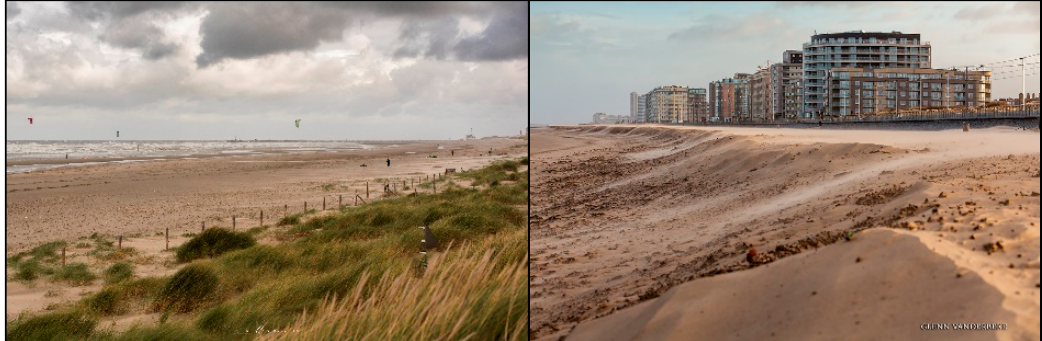
Figure 5. Typical sights at the Belgian coast. Left: natural beach-dune system at Koksijde (11 km from the French border). Right: managed beach-dyke system at Mariakerke (26 km from the French border).